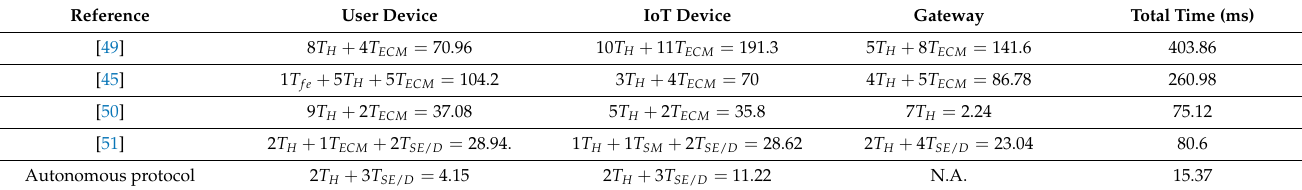
Table 7. Computational overhead in IoT schemes.